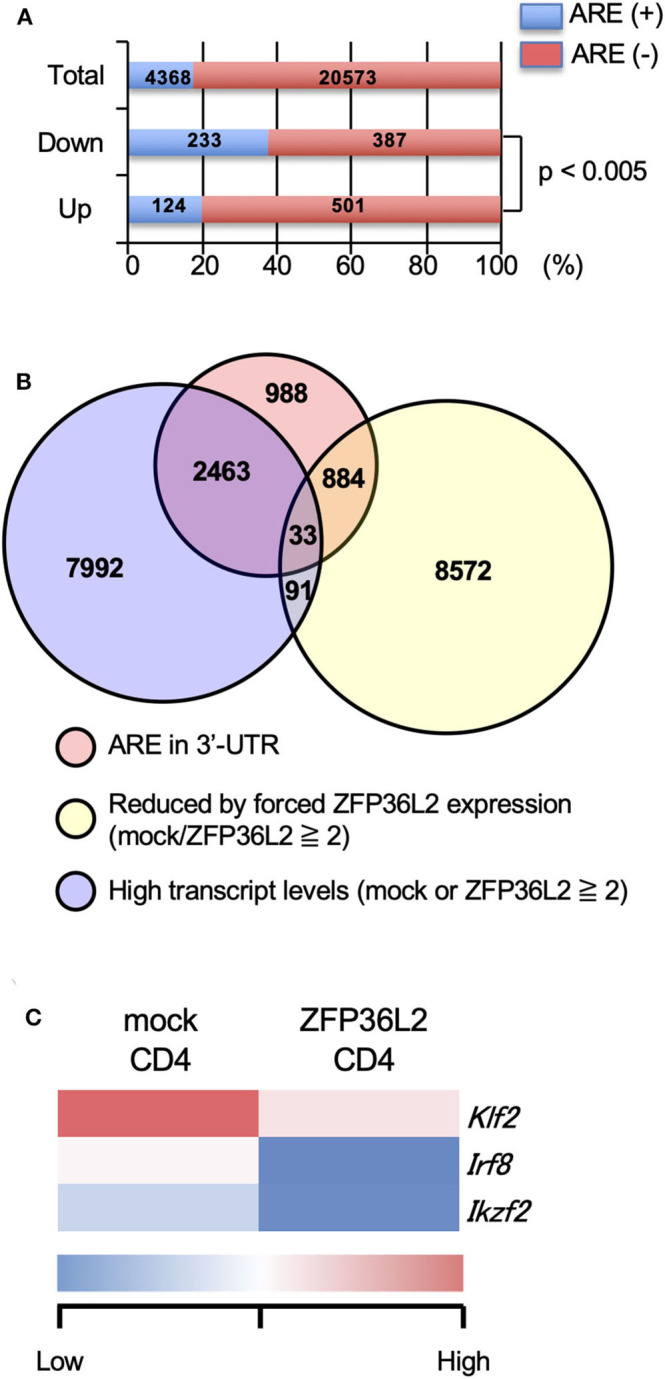
Ikzf2 (encoding Helios) is downregulated by forced ZFP36L2 expression. (A–C) After naïve CD4+ T cells were stimulated with anti-CD3/anti-CD28 mAb under neutral conditions for 24 h, cells were infected with retroviruses of MSCV-IRES-GFP-Zfp36l2 (MIG-Zfp36l2) or MIG, and cultured under neutral conditions. Three days later, GFP+ cells from MIG-Zfp36l2-infected CD4+ T cells and from MIG-infected CD4+ T cells were isolated by flow cytometry. Total RNAs were prepared from these cells and subjected to RNA-seq analysis. (A) Quantification of mRNAs with or without AREs in 3′UTR of mRNA downregulated (Down) or upregulated (Up) in CD4+ T cells by ZFP36L2 expression (transcript levels ≧2, fold change ≧1.5). (B) Venn diagram showing the overlap of indicated criteria in mRNAs expressed in CD4+ T cells. (C) Shown is a heat map of differentially expressed genes encoding transcriptional factors among 33 genes enriched in (B).